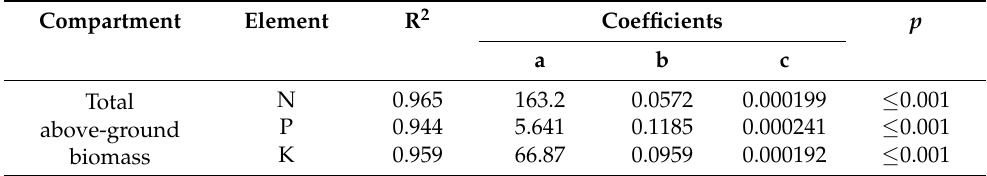
Table 4. Models for the estimation of nutrient storage (kg/hm 2 ) as a function of dbh (cm) and density (individual/hm 2 ) for the total above-ground biomass of Moso bamboo in